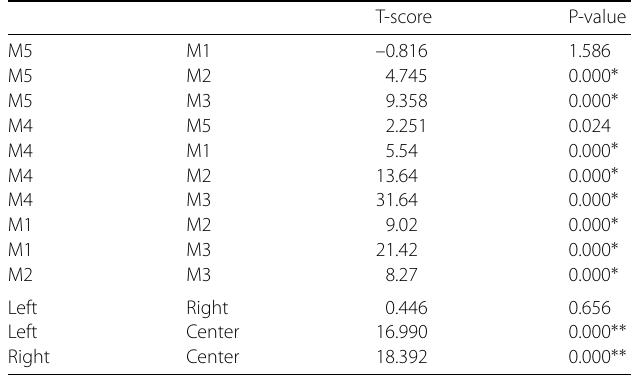
Table 6 Results for the corrected paired t-tests for ideological leaning